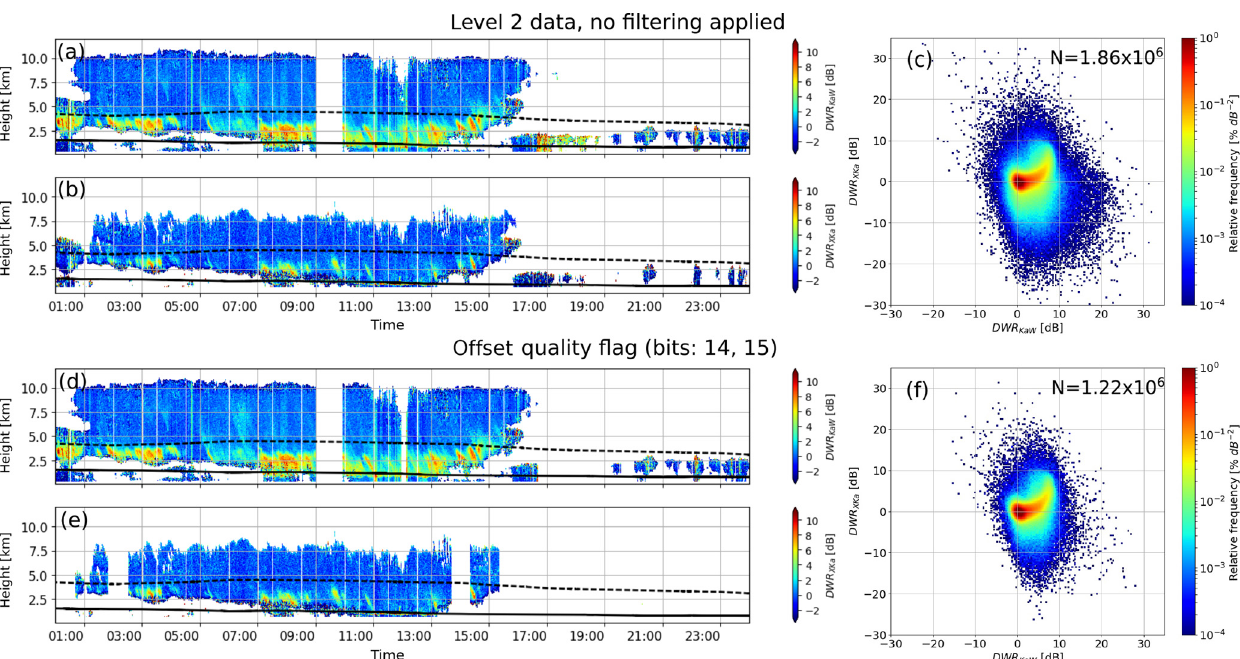
Figure 4. Time–height plots of DWR KaW (a) and DWR XKa (b) using the Level 2 data of 20 November 2015 without applying any filtering. The continuous line and dashed line are the 0 and − 15 ◦ C isotherms (provided by the CloudNet products), respectively. The triple-frequency signatures for the ice part of the clouds are shown in (c) . Panels (d–f) show the remaining data after applying the offset quality flags and the restriction to data pairs with sufficient correlation. N in (c, f) indicates the respective number of data pairs in the ice part of the clouds. Note the log scale on the color bars in (c, f)